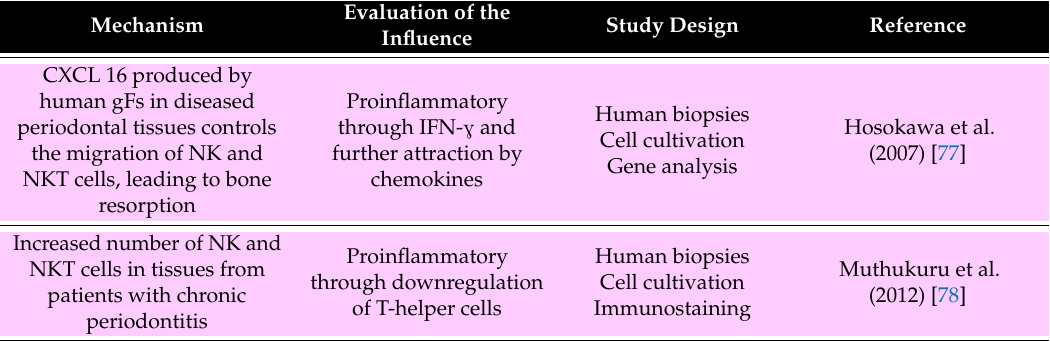
Table 3. Combined NK cell- / NKT cell-mediated mechanisms in periodontitis. NK—natural killer cell; NKT—natural killer T cell; gF—gingival fibroblast; CXCL—CXC-motif ligand chemokine; and IFN- G —interferon